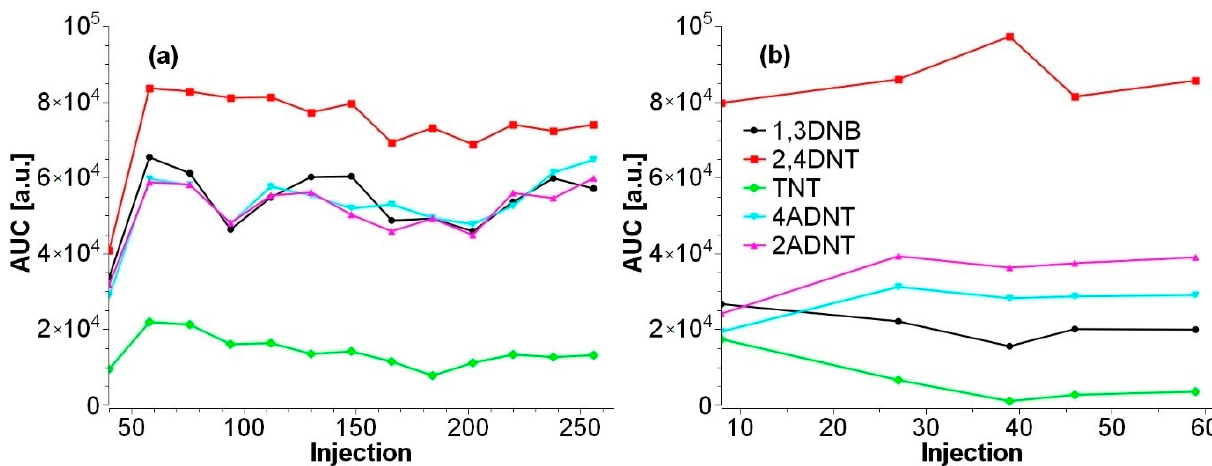
Figure 5. Course of the peak area of an external standard of ( a ) 10 ng/mL injected after every 16 measurements for a batch of 220 mussel samples prepared according to Strehse et al. 2017 and measured by splitless injection, and ( b ) 1 ng/mL 50 freeze-dried/SPE extracted samples measured by PTV-LVI. The intensity of TNT decreased by 50% (splitless) and 90% (PTV-LVI) during measurements, while the intensities of the other explosives increased slightly after the first measurements and then remained at the same level. For the splitless method, 13 C 15 N-TNT was used as an internal standard to correct the area of TNT.